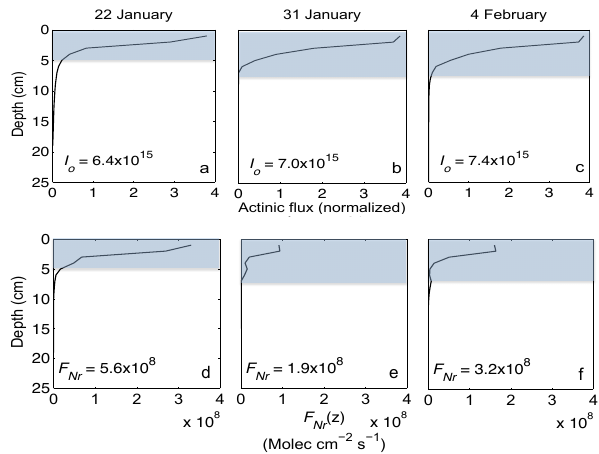
Figure 4. (a–c) Modeled vertical profiles of UV actinic flux ( I , photonscm − 2 s − 1 ) normalized to surface downwelling irradiance ( I o , photonscm − 2 s − 1 ) . Also presented is measured total UV I o ( λ = 300–350nm) for a solar zenith angle of 60 ◦ on each day. (d–f) Modeled vertical profiles of snow-sourced N r fluxes ( F N , r moleccm − 2 s − 1 ) calculated using Eq. (3). Also shown is total F N , r which is the depth-integrated F N over the photic zone. The blue r shaded region represents the snow photic zone.